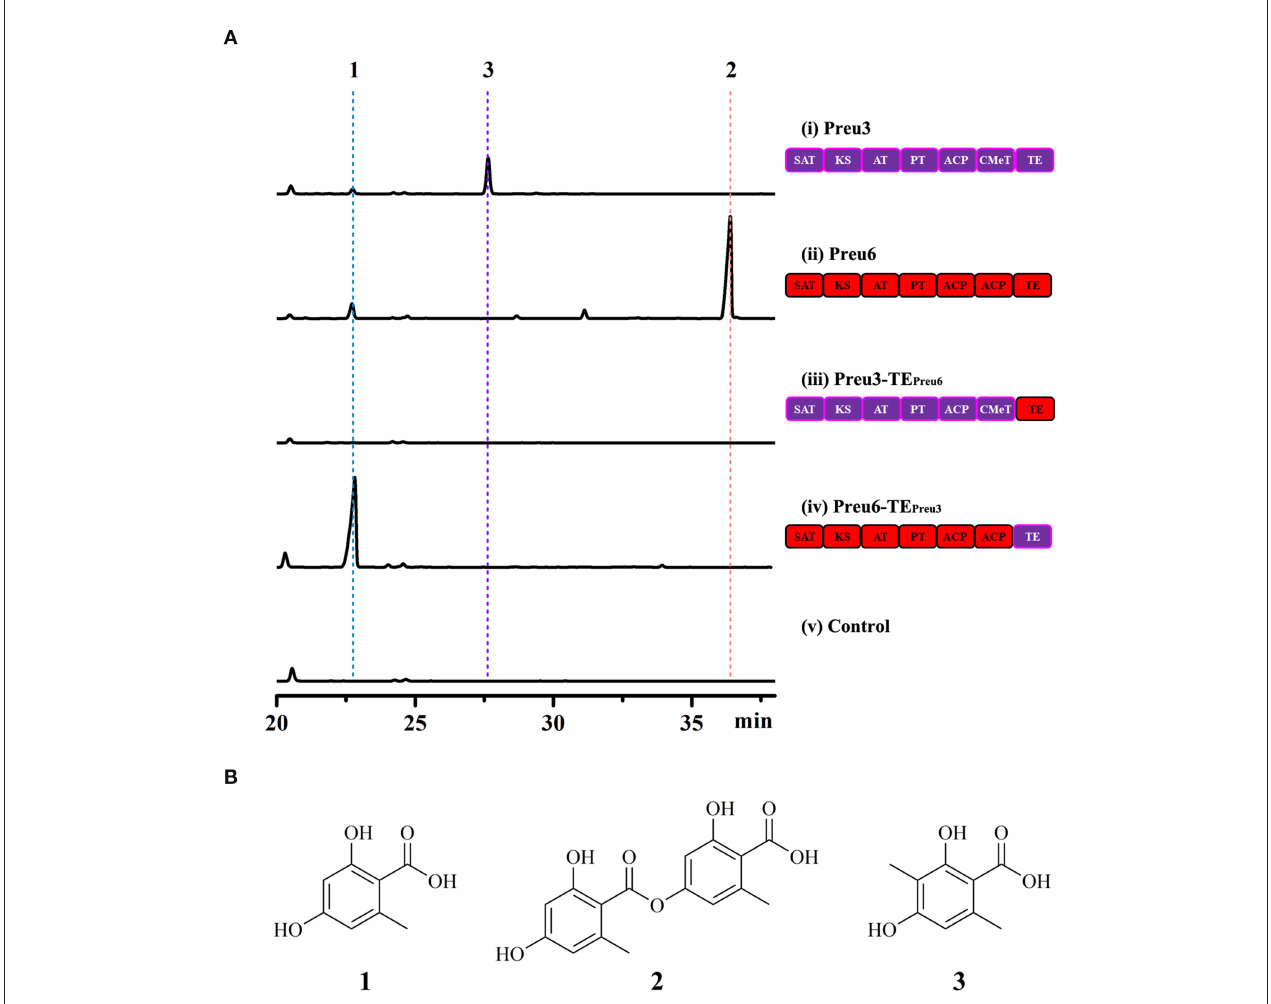
FIGURE 3 | Heterologous expression of the PKSs originated from P. isomera XL-1326 in S. cerevisiae BJ5464-NpgA. (A) HPLC traces (DAD, 300nm) of crude extracts of the cultures of the indicated strains cultivated for 72h after adding the YPD medium. Control, S. cerevisiae BJ5464-NpgA strain with empty vector YEpADH2p-FLAG-URA. (B) Structures of the OA